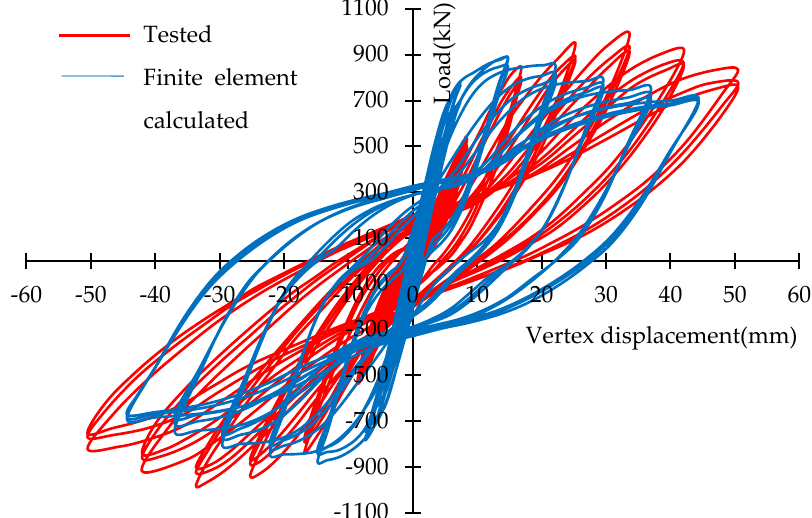
Figure 8. Load–displacement hysteresis curves. Figure 8. Load‒displacement hysteresis curves. Figure 8. Load‒displacement hysteresis curves.